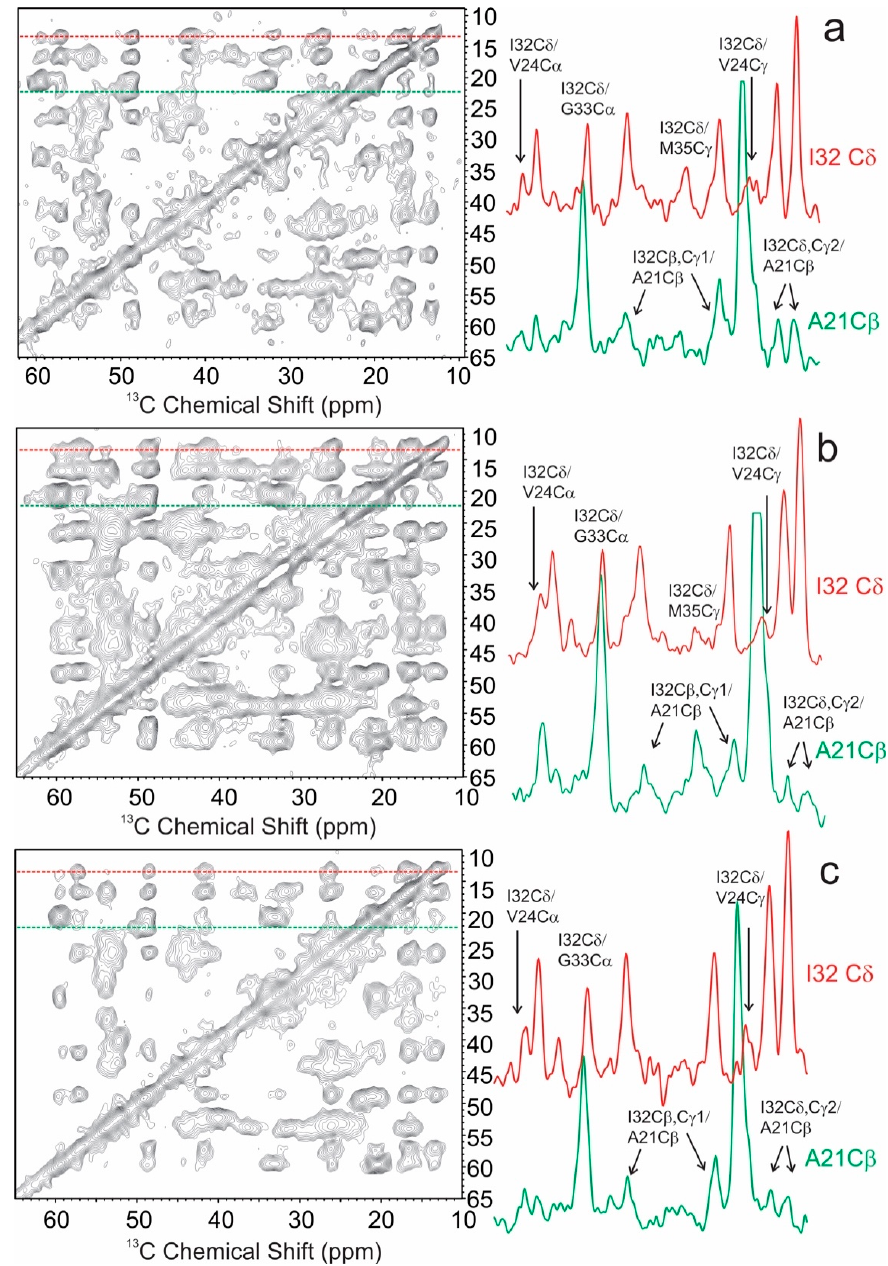
Figure 6. Representative long-mixing (500 ms) 2D 13 C– 13 C spin diffusion spectra for A β 40 fibrils ( a ) MM1, ( b ) MM2 and ( c ) BM2 membrane models. The same labeled samples were utilized as in Figure 4. The 1D slices highlight the inter-residue cross peaks between I32 and V24, G33, and M35, as well as between A21 and I32 in all samples.